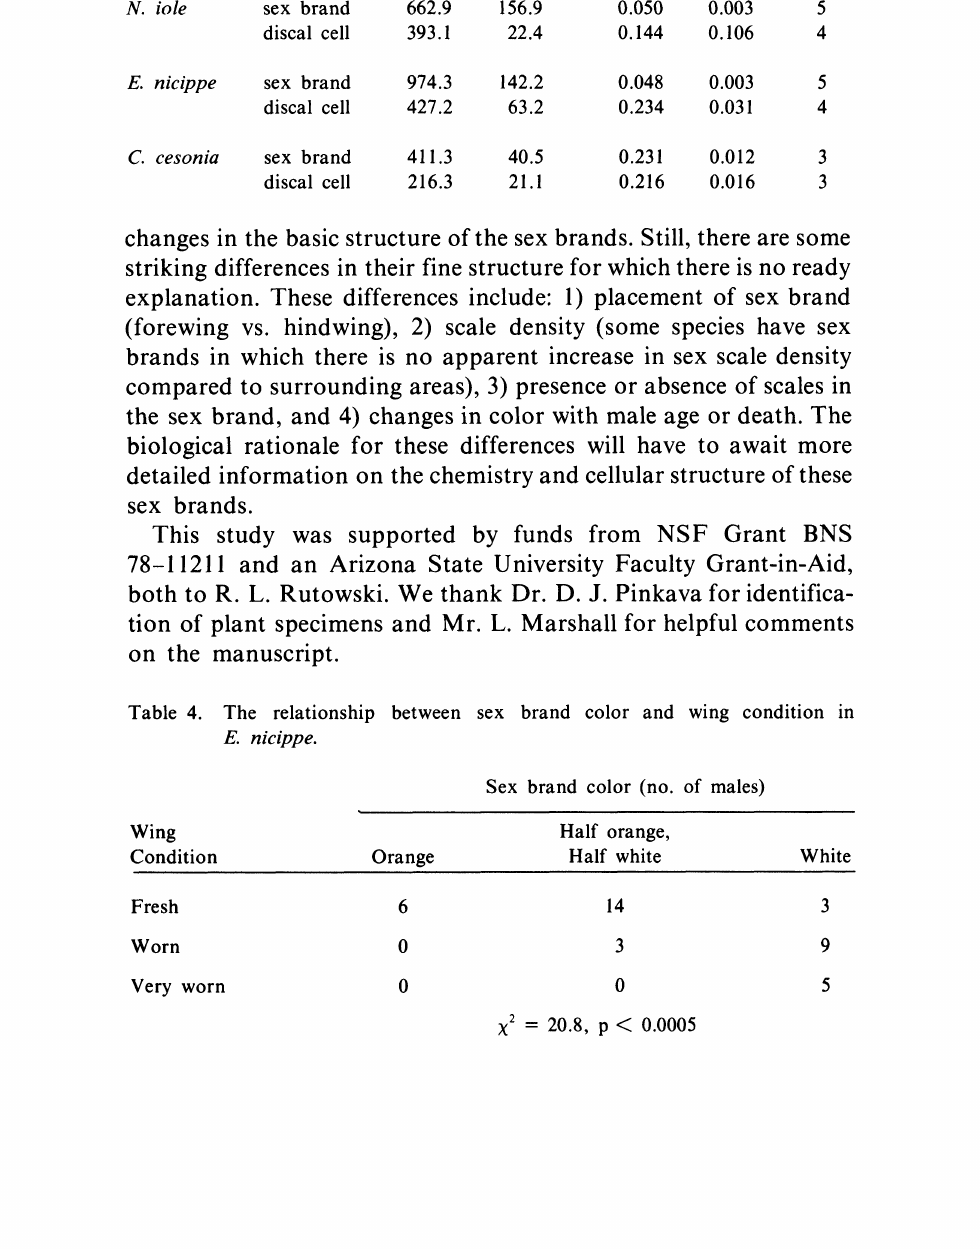
Table 3. Scale attachment densities for the wings of three pierid butterflies.